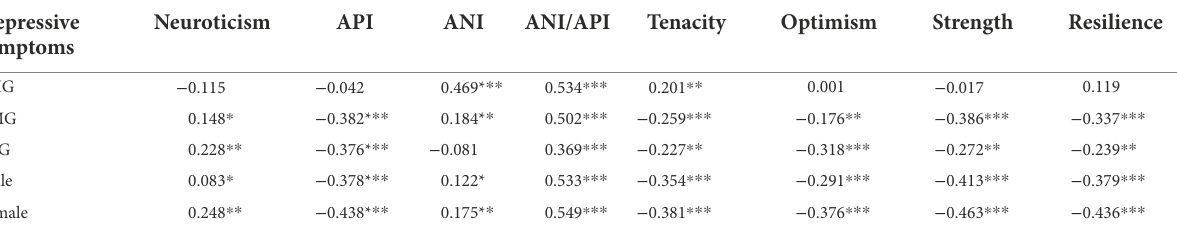
TABLE 5 Correlation analysis of depressive symptoms, neuroticism, attentional bias, and resilience in RHG, RMG, RLG, male, and female. Depressive symptoms